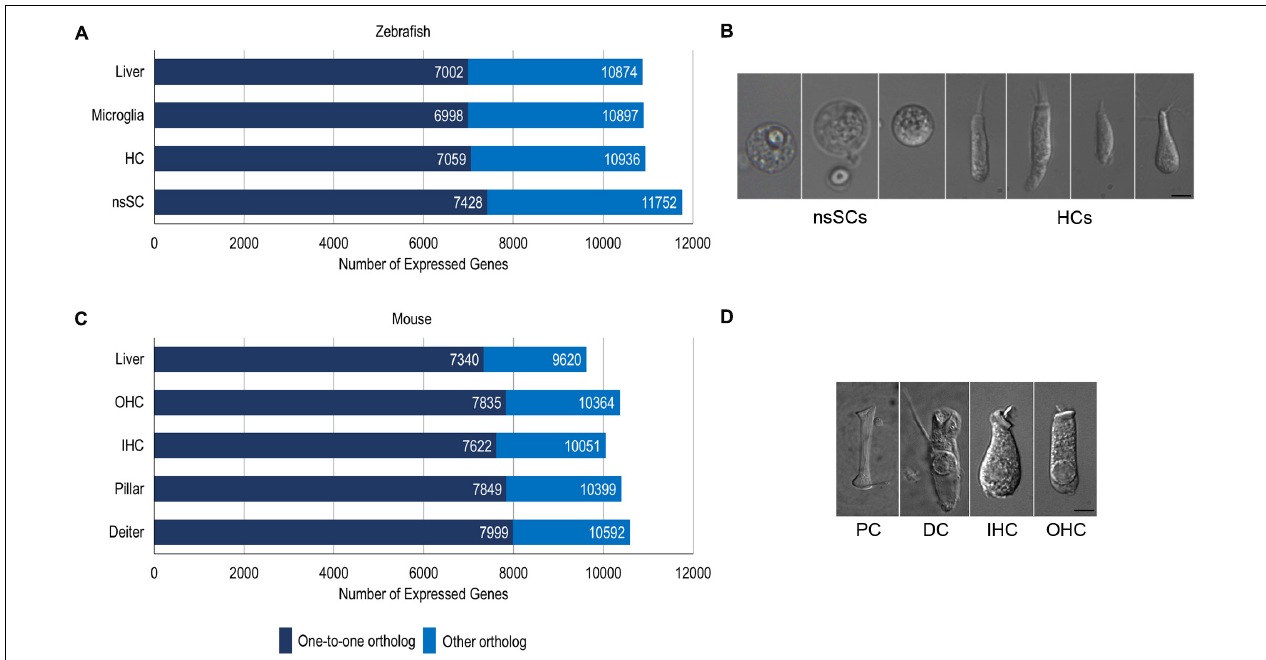
FIGURE 1 | Cell type-specific gene expression in zebrafish and mouse. (A) The total number of expressed gene orthologs (RPKM ≥ 0.10, FDR-adjusted p -value ≤ 0.10) in zebrafish nsSCs, HCs, microglia, and liver. The number of expressed one-to-one orthologs out of the total number of classified orthologs is shown in dark blue. (B) Representative images of zebrafish nsSCs and HCs; Bar: 5 µ m. (C) The total number of expressed gene orthologs (RPKM ≥ 0.10, FDR-adjusted p -value ≤ 0.10) in mouse DCs, PCs, IHCs, OHCs, and liver cells. (D) Representative image of a mouse PC, DC, IHC, and OHC; Scale bar: 5 µ m (adapted from Liu et al.,